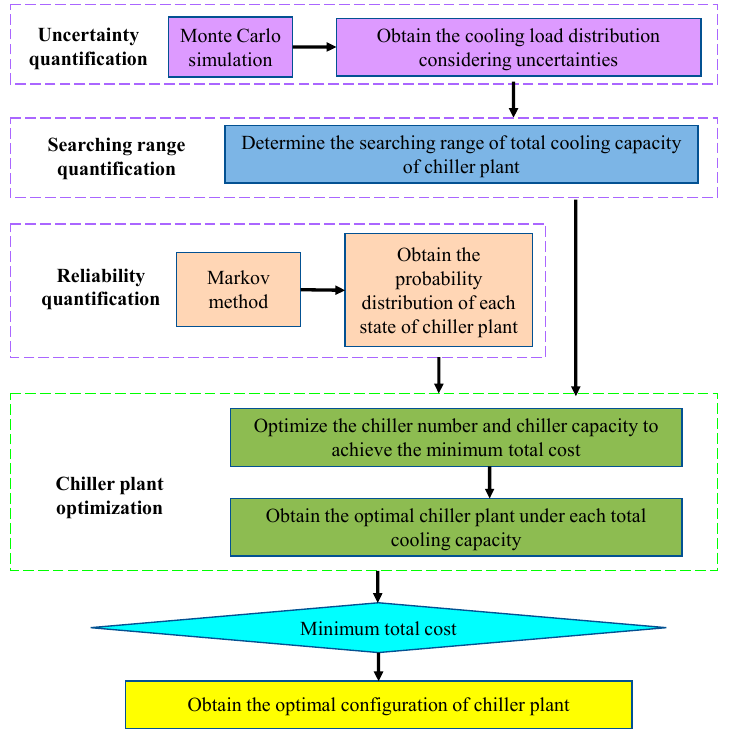
Figure 3. Procedure of the proposed robust optimal design.